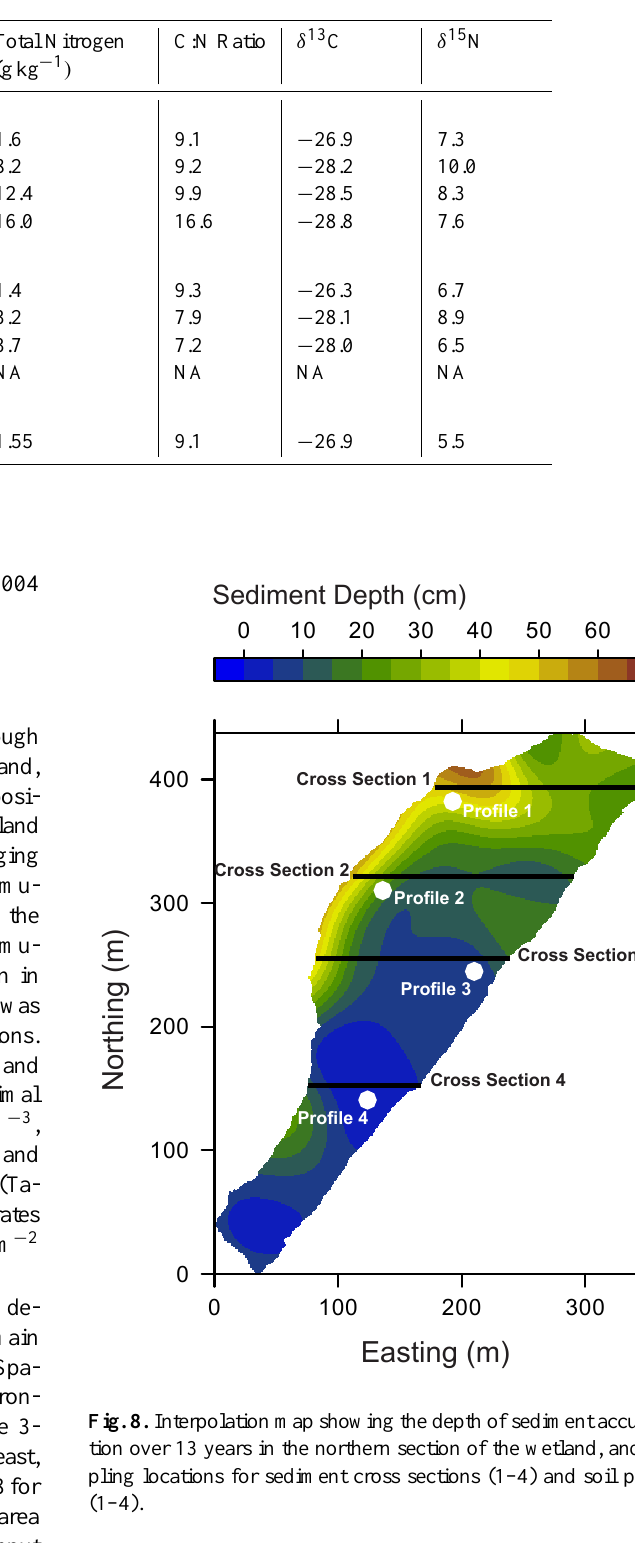
Table 3. Total carbon, total nitrogen, C:N ratio, δ 13 C, and δ 15 N for suspended sediment, sediment, and vegetation in 2004, 2005, and a 13-year average for the whole wetland.